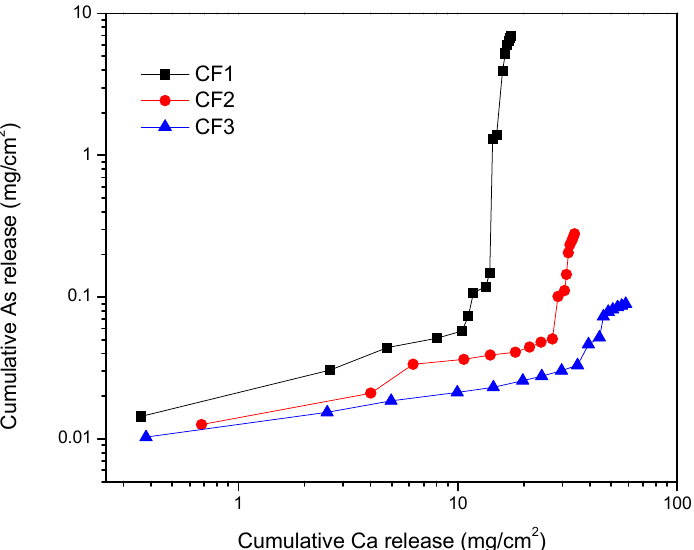
Figure 9. Variation of cumulative leached calcium with cumulative leached arsenic from cement- encapsulated samples.